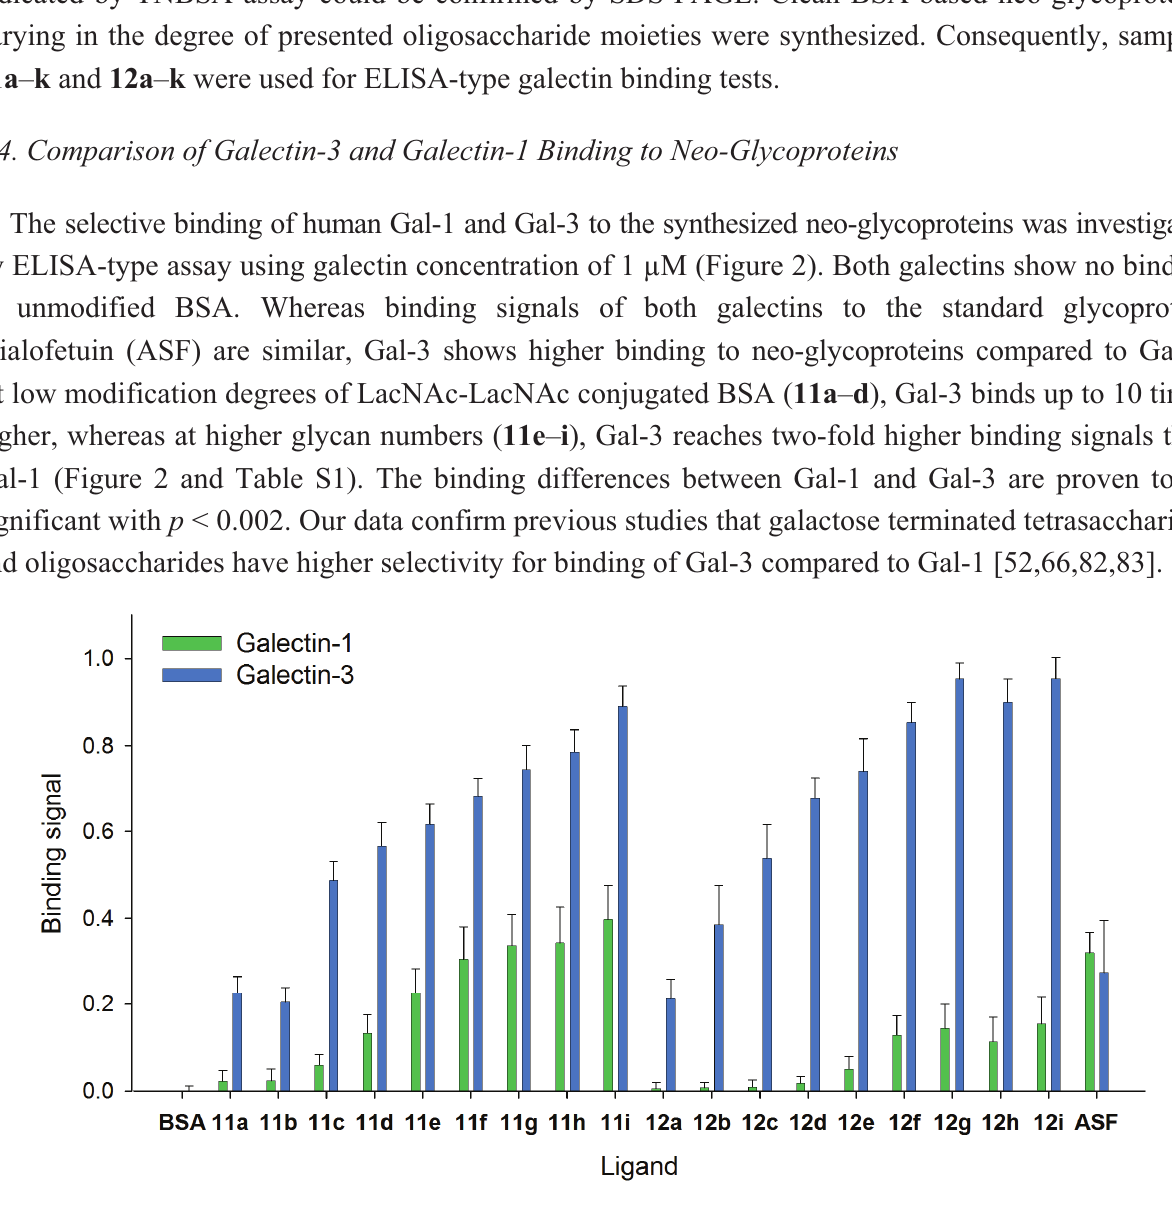
Figure 2. Comparison of galectin-1 and galectin-3 binding to immobilized neo-glycoproteins 11a – i and 12a – i . For neo-glycoproteins, binding signals of 1 μM galectin-1 ((cid:4)) and 1 μM galectin-3 ((cid:4)) are compared. Galectin binding to immobilized neo-glycoproteins as well as to unmodified BSA is shown. All galectin-3 binding signals are significantly higher than those of galectin-1 ( p <